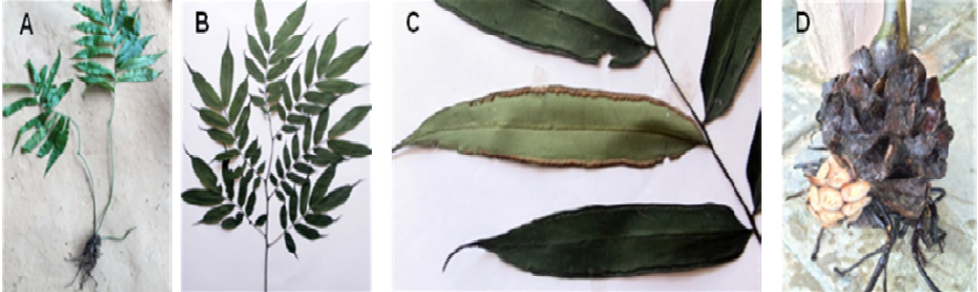
Figure 1. Photographs of different plant parts of A. helferiana : ( A ) Whole plant at early stage; ( B ) leaf (frond) of matured plant; ( C ) leaf bearing sori at the margin; and ( D ) rhizome.